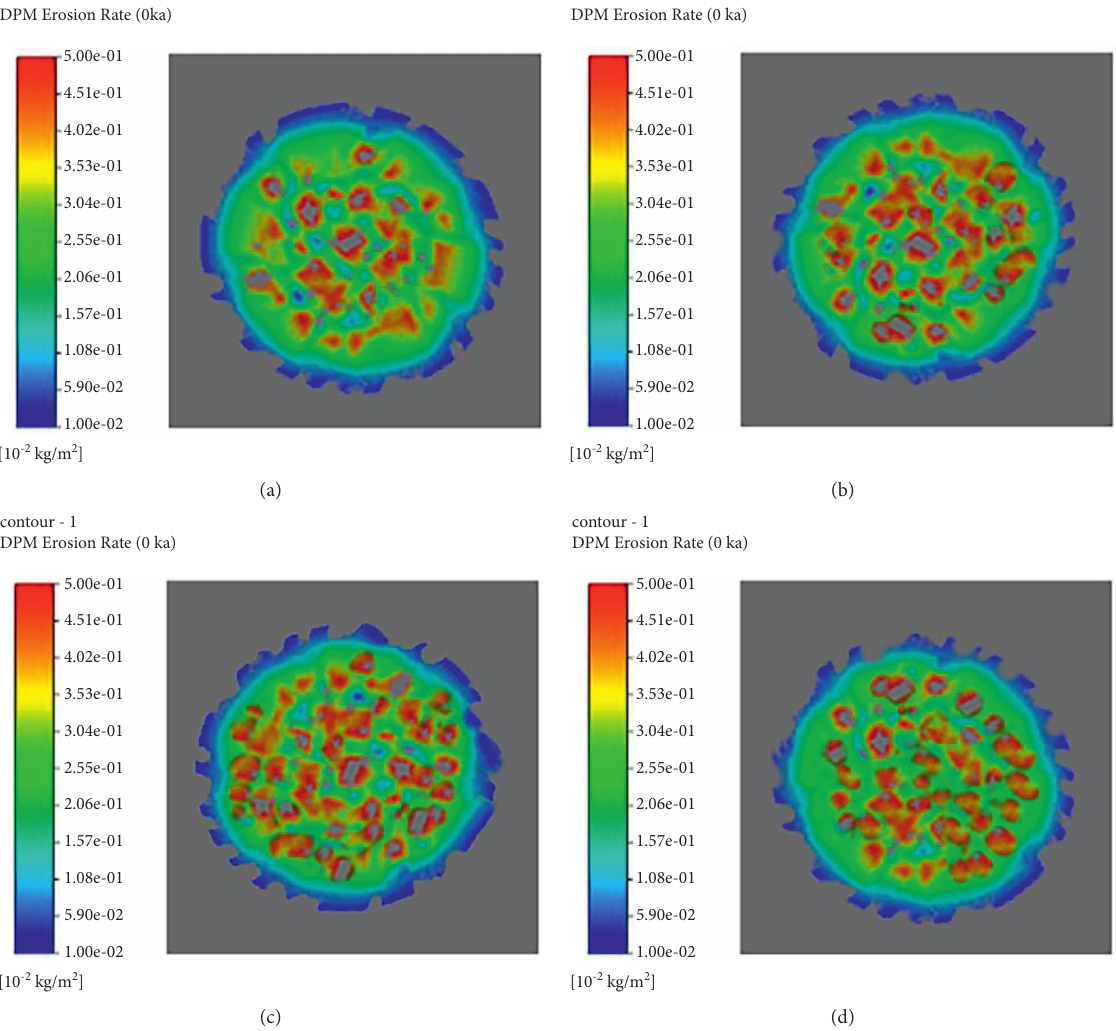
Figure 15: The erosion of the blade surface with different abrasive diameters. (a) The erosion of the blade surface with the abrasive diameter of 0.2mm. (b) The erosion of the blade surface with the abrasive diameter of 0.3mm. (c) The erosion of the blade surface with the abrasive diameter of 0.4mm. (d) The erosion of the blade surface with the abrasive diameter of